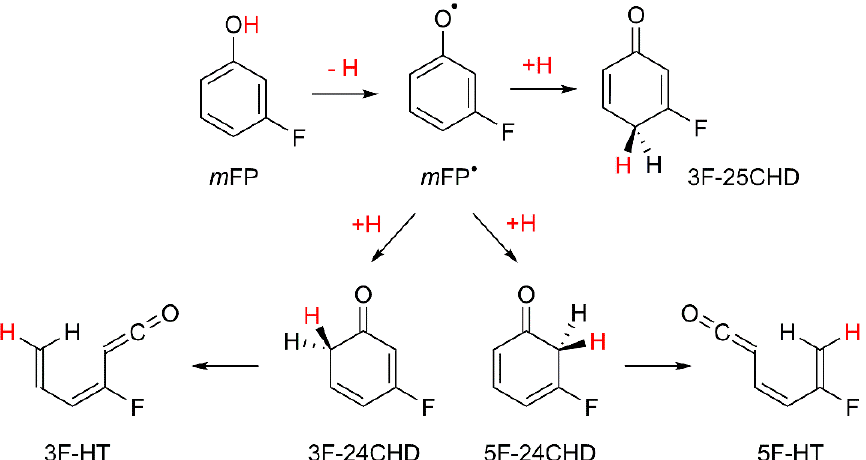
Scheme 2. Isomerization pathways resulting from UV-irradiation of m FP isolated in an Ar matrix at 16 K ( λ = 270 nm).